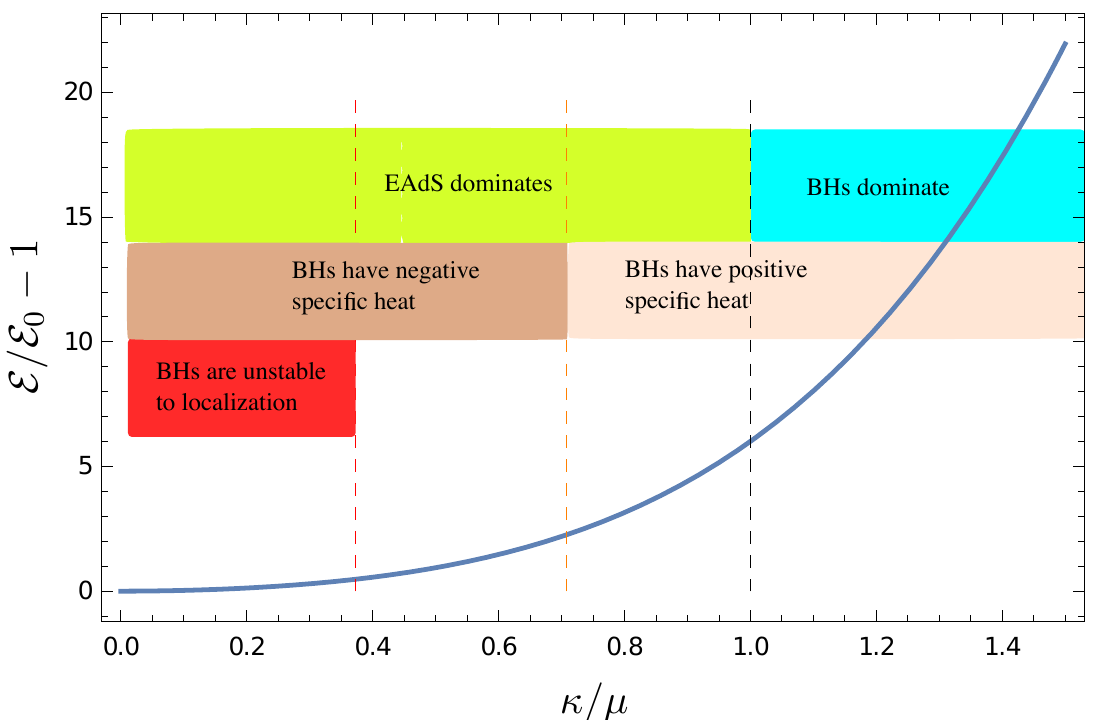
T 1 , 1 . The energy density ×